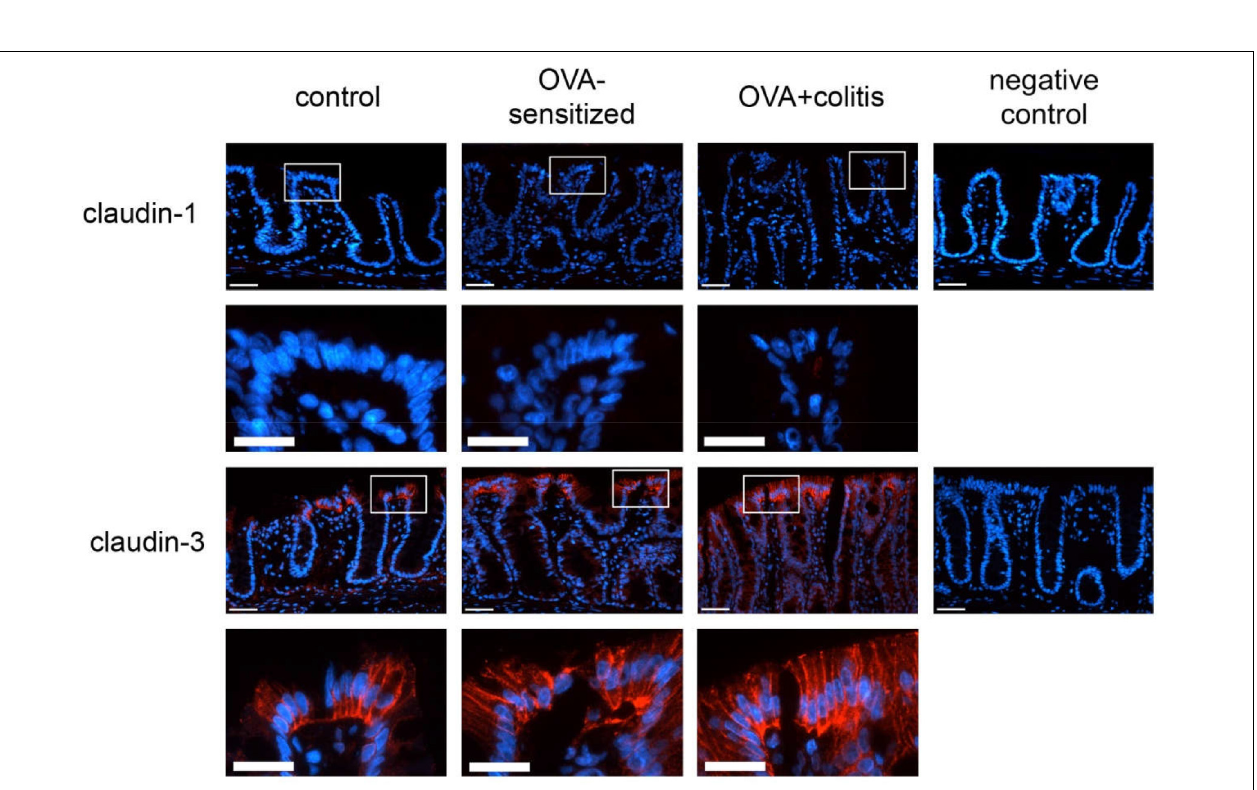
FIGURE 5 | Expression of claudin-1 (upper two rows) and claudin-3 (lower two rows) in rat colon under control conditions (1st column), in OVA-sensitized animals (2nd column), and in OVA+colitis animals (3rd column). The 4th column shows negative controls where the primary antibody against the respective claudin was omitted. Row 2 and 4 show enlargements of the pictures presented in the respective upper rows (with a rectangle depicting the localization of the magnifications). Thin calibration bar (1st and 3rd row): 50 µ m; thick calibration bar (2nd and 4th row): 25 µ m. Representative staining of three independent experiments for each claudin